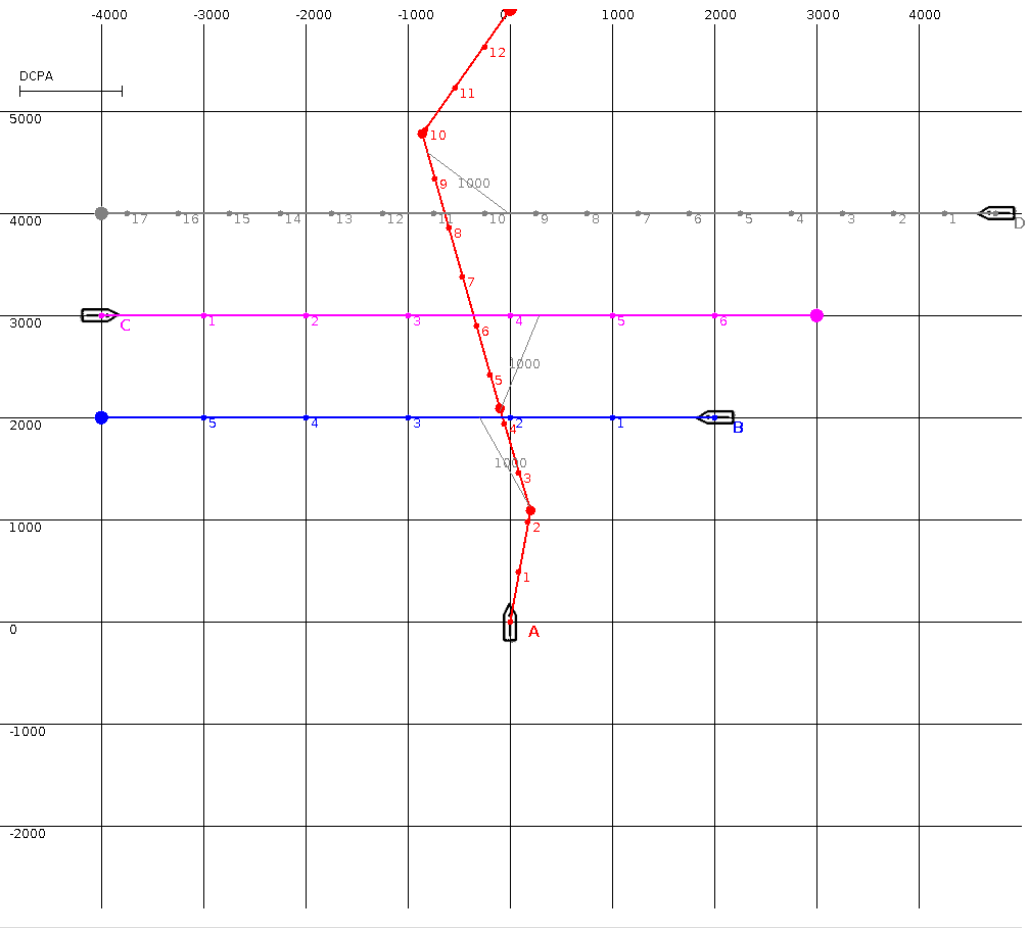
Figure 2. An encounter situation involving four (A, B, C, and D) surface vehicles. The trajectories of target surface vehicles B, C, and D are marked accordingly in blue, pink, and grey. The anti-collision trajectory for A surface vehicle proposed by the MBSA is marked in red.